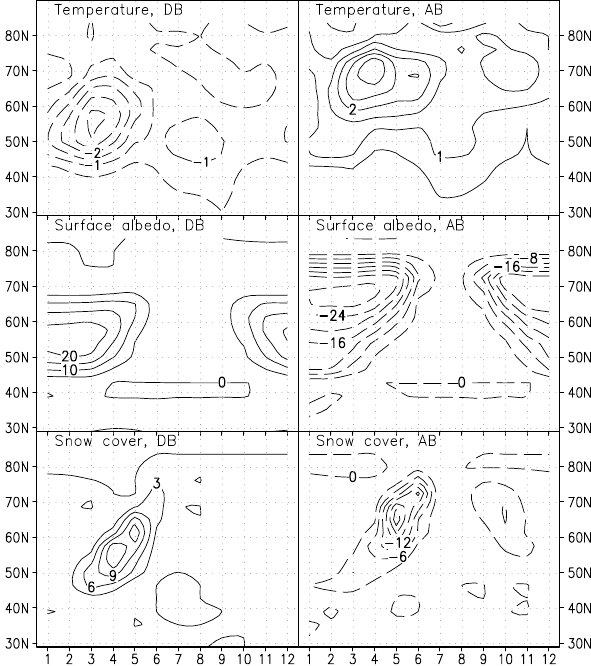
Fig. 12. Surface temperature anomalies in ◦ C, albedo and snow cover in %, zonally averaged over all land cells during the final 200years for boreal deforestation (left) and boreal afforestation